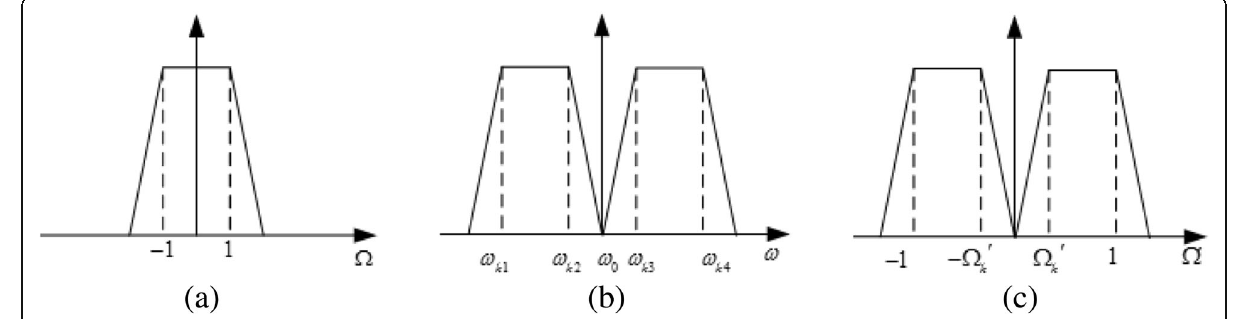
Fig. 1 Schematic diagram of dual-passband frequency conversionb. a The Ω domain. b The Ω ′ domain. c The ω